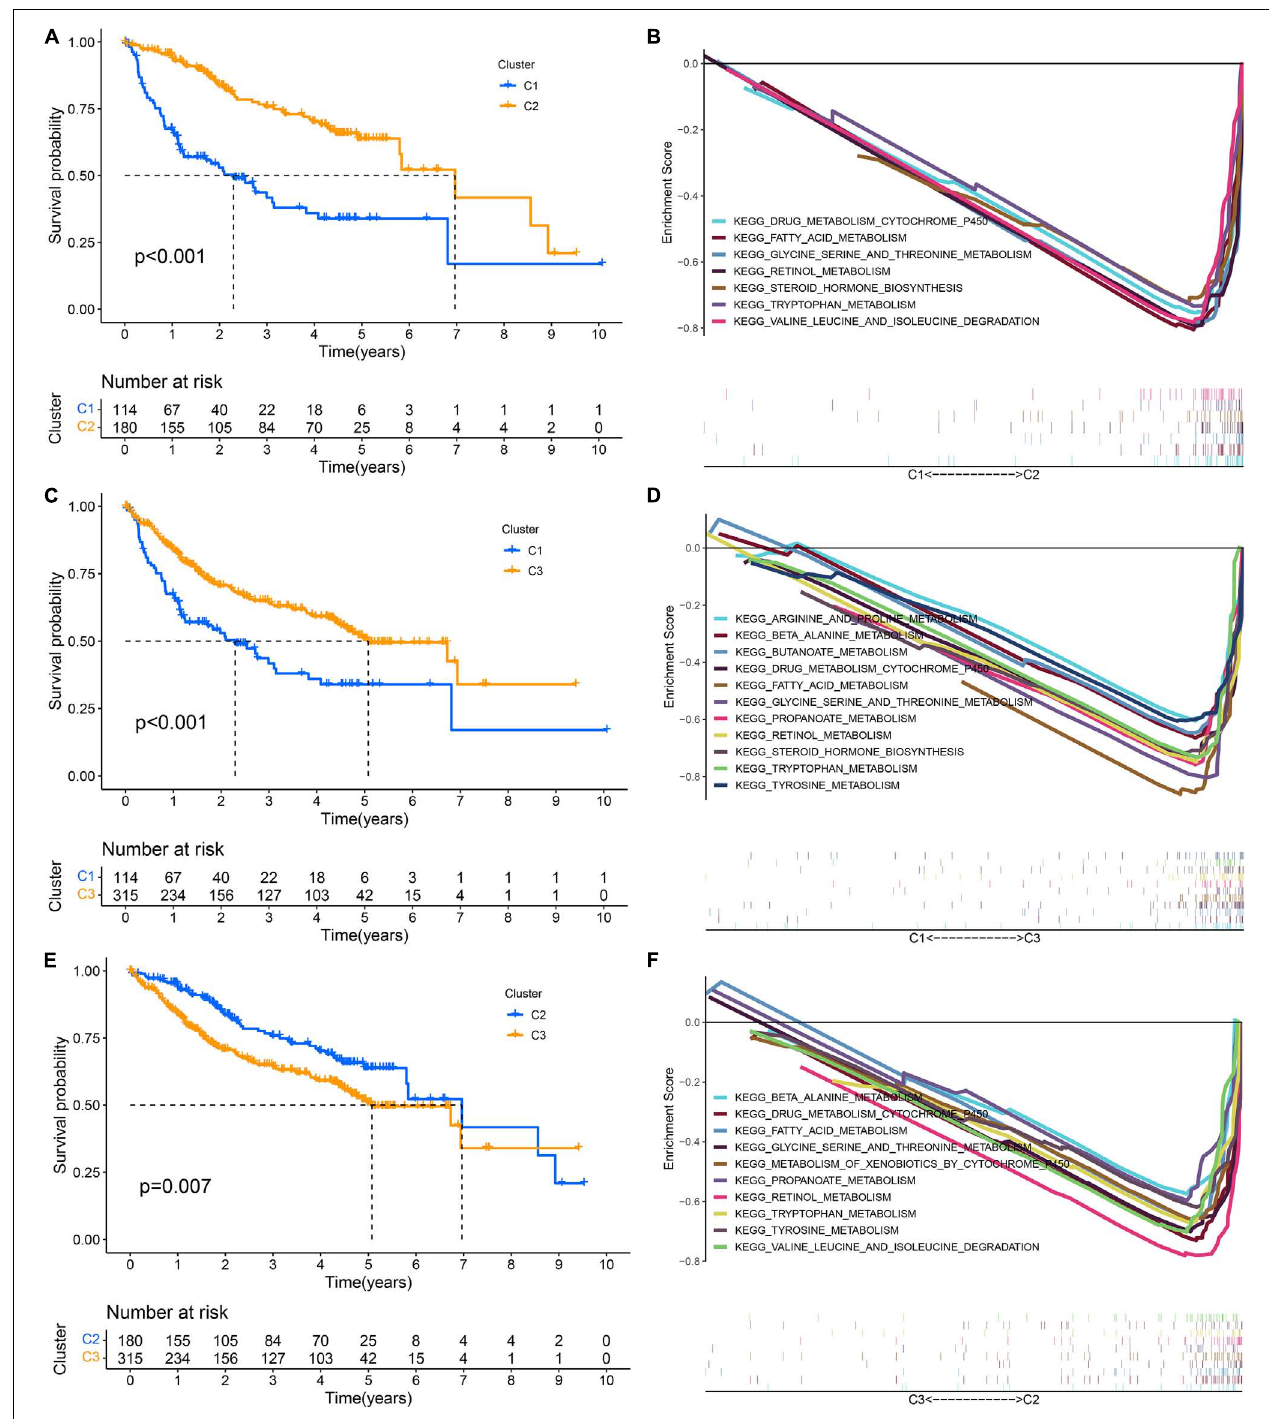
FIGURE 11 | Pairwise comparison of metabolism activity among the three subtypes. (A,B) C1–C2. (C,D) C1–C3. (E,F) C2–C3.